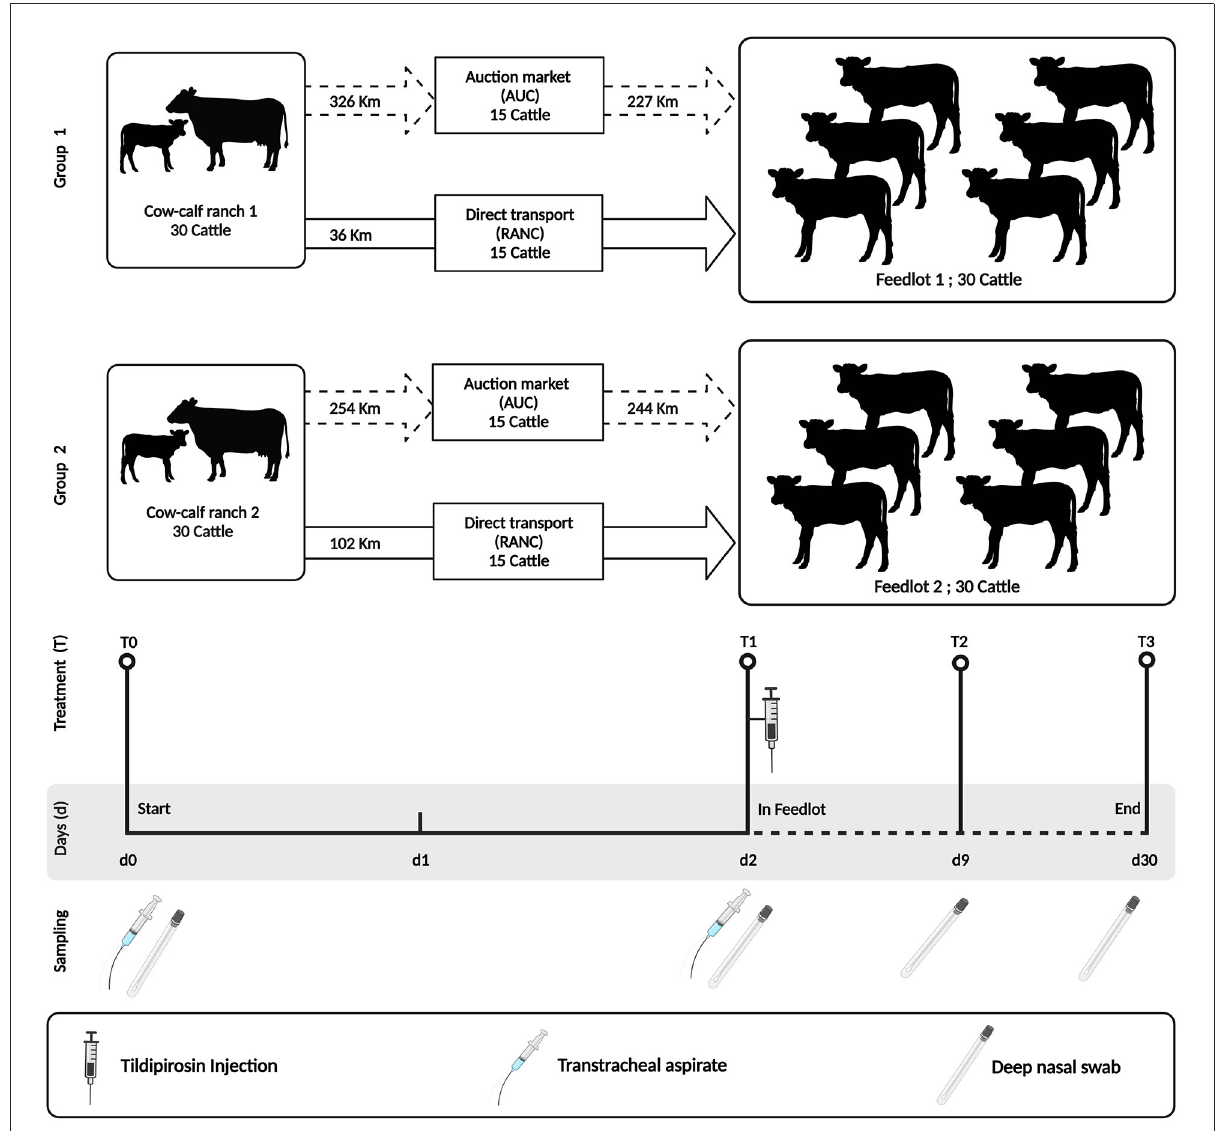
FIGURE1 Study design indicating sampling time points and antimicrobial treatment. The study was performed using two groups of cattle ( N = 30 per group). Group 1 cattle were placed in a high-capacity feedlot housing ∼ 4,000 cattle (Feedlot-1). Group 2 cattle were placed in a low-capacity feedlot housing 600 cattle (Feedlot-2). Both groups were injected with tildipirosin at feedlot entry. All cattle were sampled similarly by deep nasal swab (DNS) and/or trans tracheal aspiration (TTA) at the indicated time points (T0–T3). This figure is created with